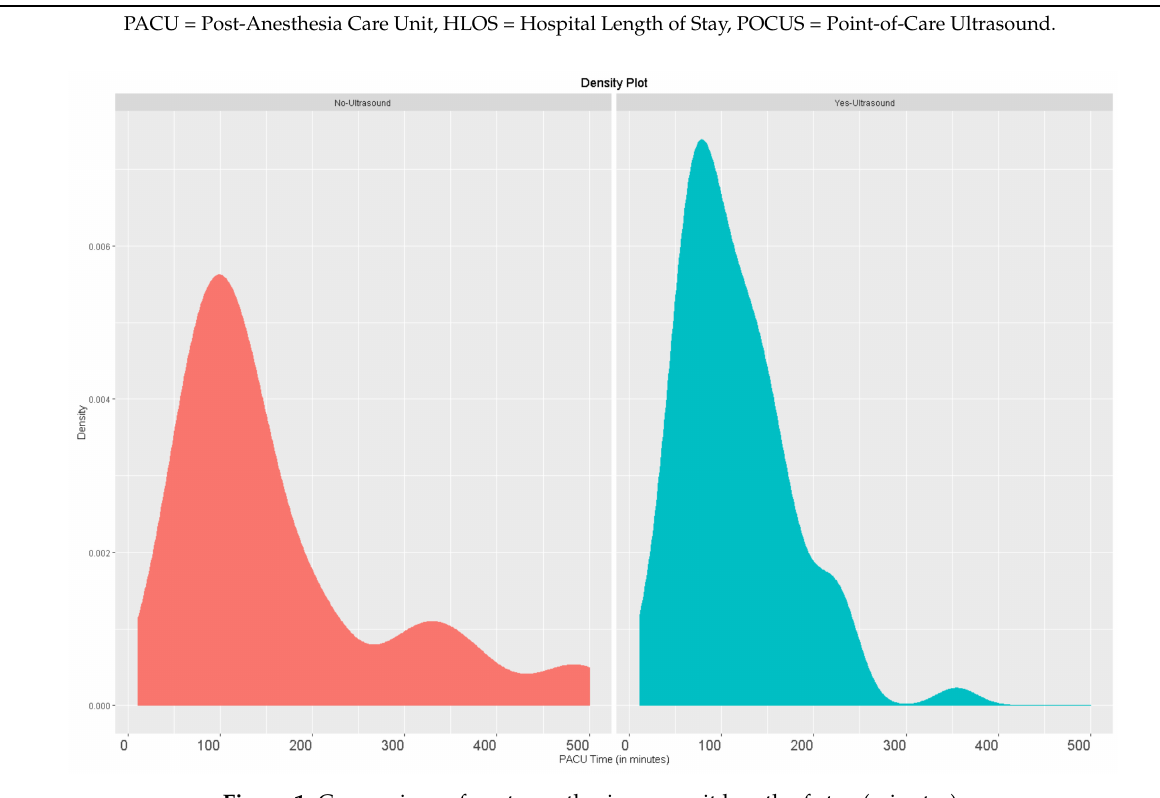
Figure 1. Comparison of post-anesthesia care unit length of stay (minutes). Hospital length of stay did not show a significant difference between groups, p -values = 0.094. Moreover, there was no difference in 30-day hospital readmission across POCUS and no-POCUS groups ( p = 1). Finally, there was a significant reduction in the number of suspected diagnoses from before to after POCUS for both pulmonary and car- diac exams, with p -values of <0.001 and <0.001, respectively (Table 3). The most common mechanisms identified by the cardiac POCUS exam were hypovolemia (50%), distributive shock (21%), and depressed ejection fraction (11%). The most common mechanisms identi- fied by the pulmonary POCUS exams were airspace disease/atelectasis (41%), pulmonary edema (32%), and pleural effusion (18%). Table 3. Comparisons of the number of suspected mechanisms to trigger PACU cardiopulmonary